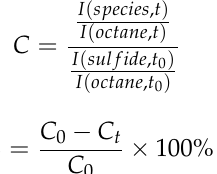
Figure S5. GC chromatograms of different catalytic reactions at 0 min and 90 min; Figure S6. SEM of aerogels before (A, B) and after catalytic reaction (C,